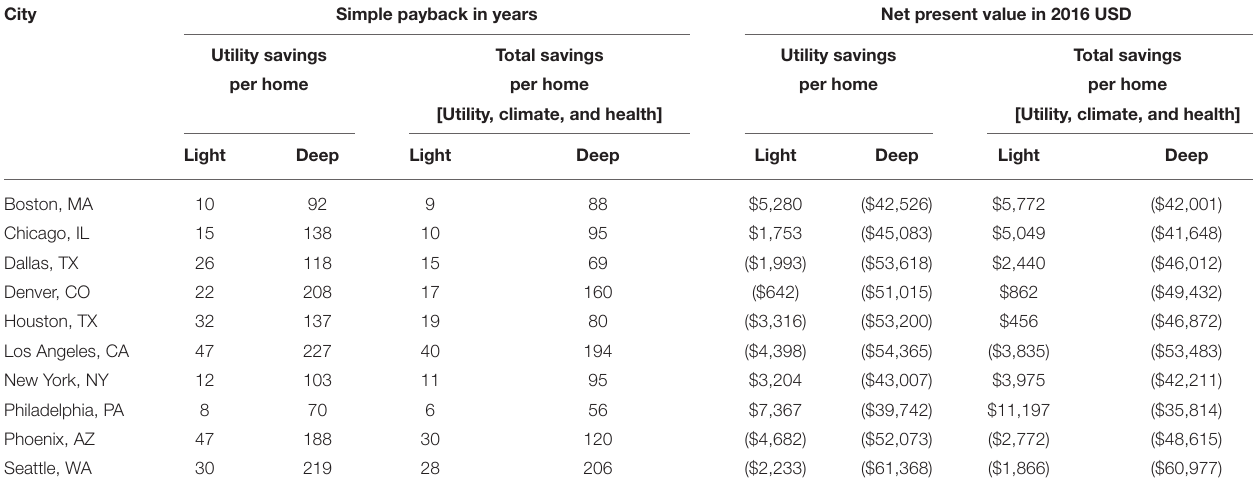
TABLE 5 | Simple Payback (years) and Net Present Value (2016 USD) of light and deep retrofits for single family detached homes built from 1990 to 2010 for city, considering the utility savings only, or the total savings (utility, climate, and health). City Simple payback in years Net present value in 2016 USD Utility savings Total savings Utility savings Total savings per home per home per home per home [Utility, climate, and health] [Utility, climate, and health] Light Deep Light Deep Light Deep Light Deep